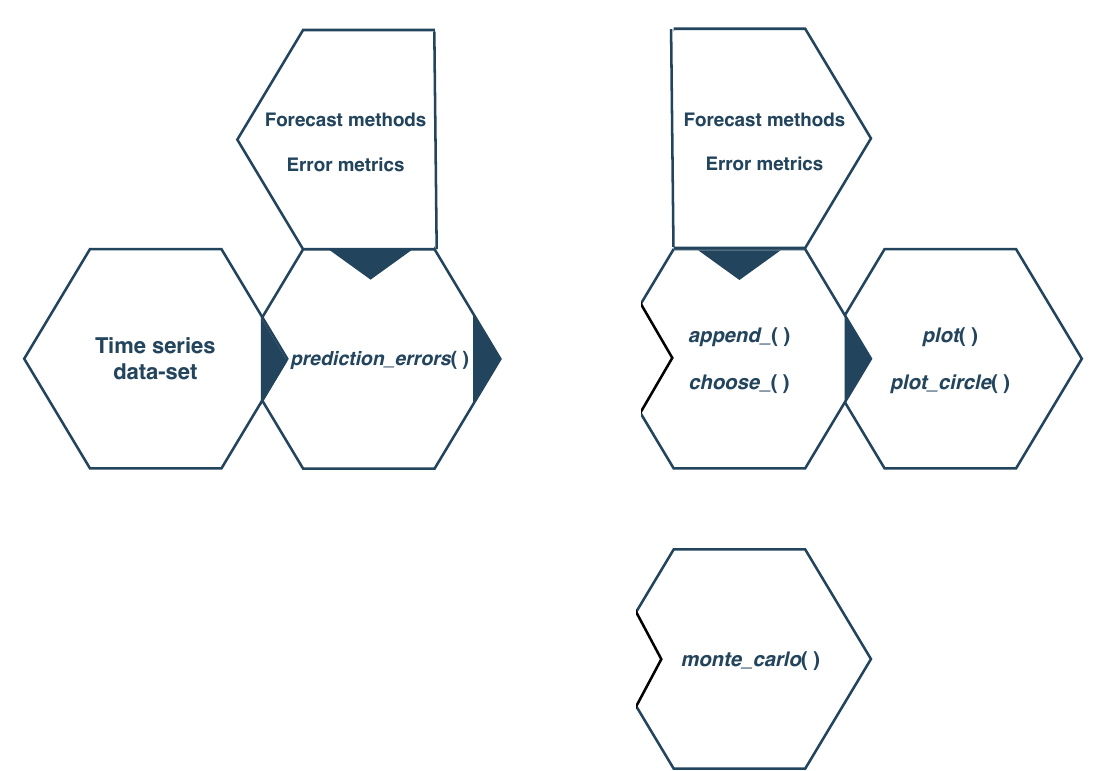
Figure 1. The plug-and-play module of the ForecastTB